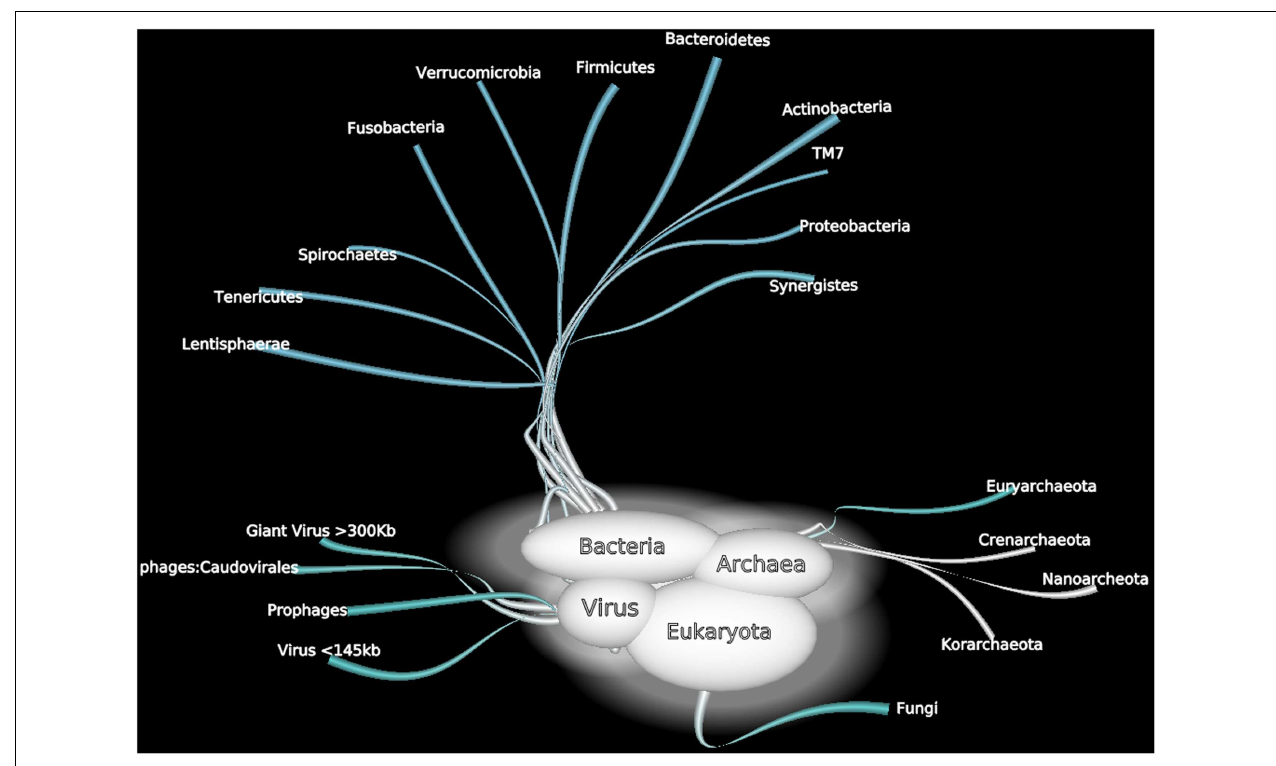
FIGURE 5 |A non exhaustive overview of human gut microorganisms among bacterial,Archaea, viral, and Eukaryota